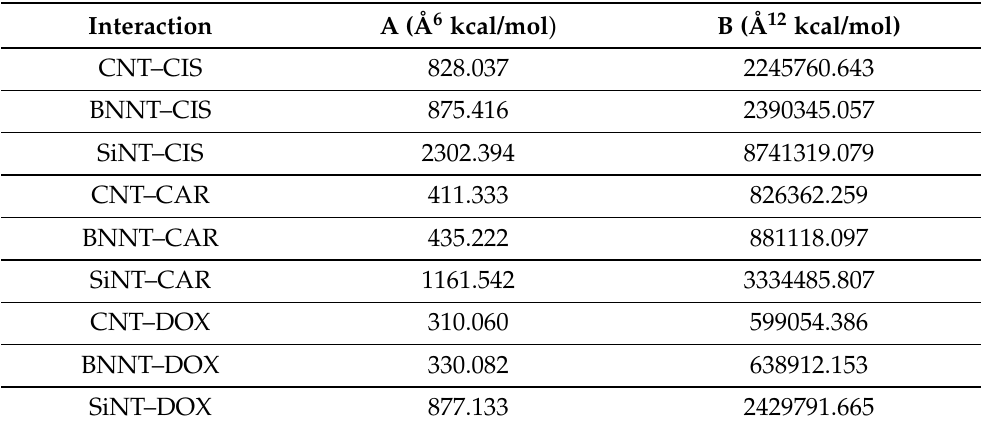
Table 1. Approximate numerical values for the Lennard–Jones parameters (attractive A and repulsive B).